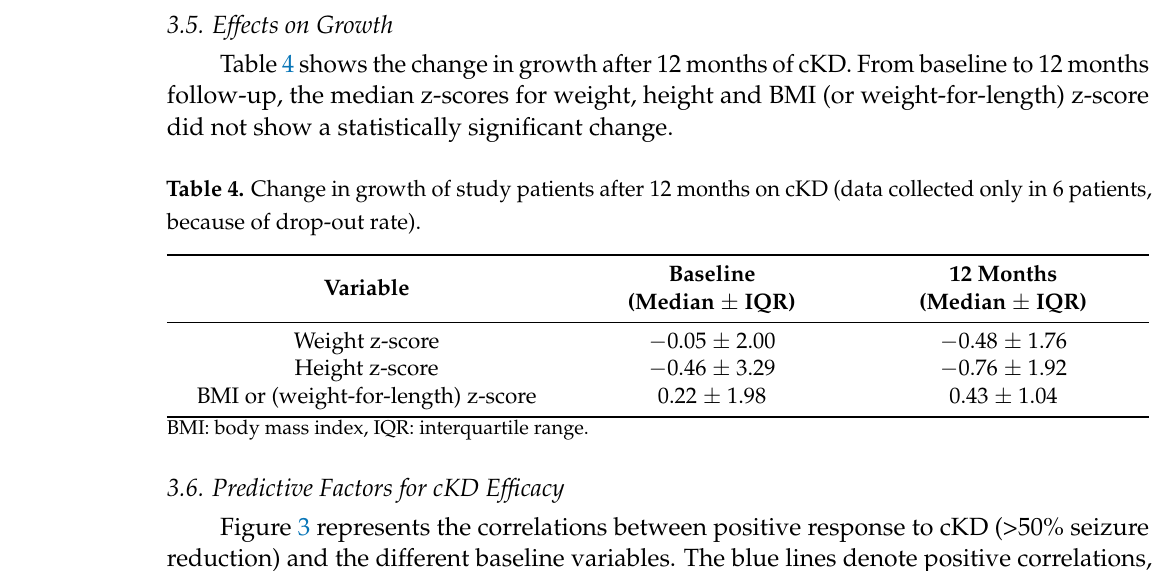
Figure 3 represents the correlations between positive response to cKD (>50% seizure reduction) and the different baseline variables. The blue lines denote positive correlations, and the numbers represent the correlations between